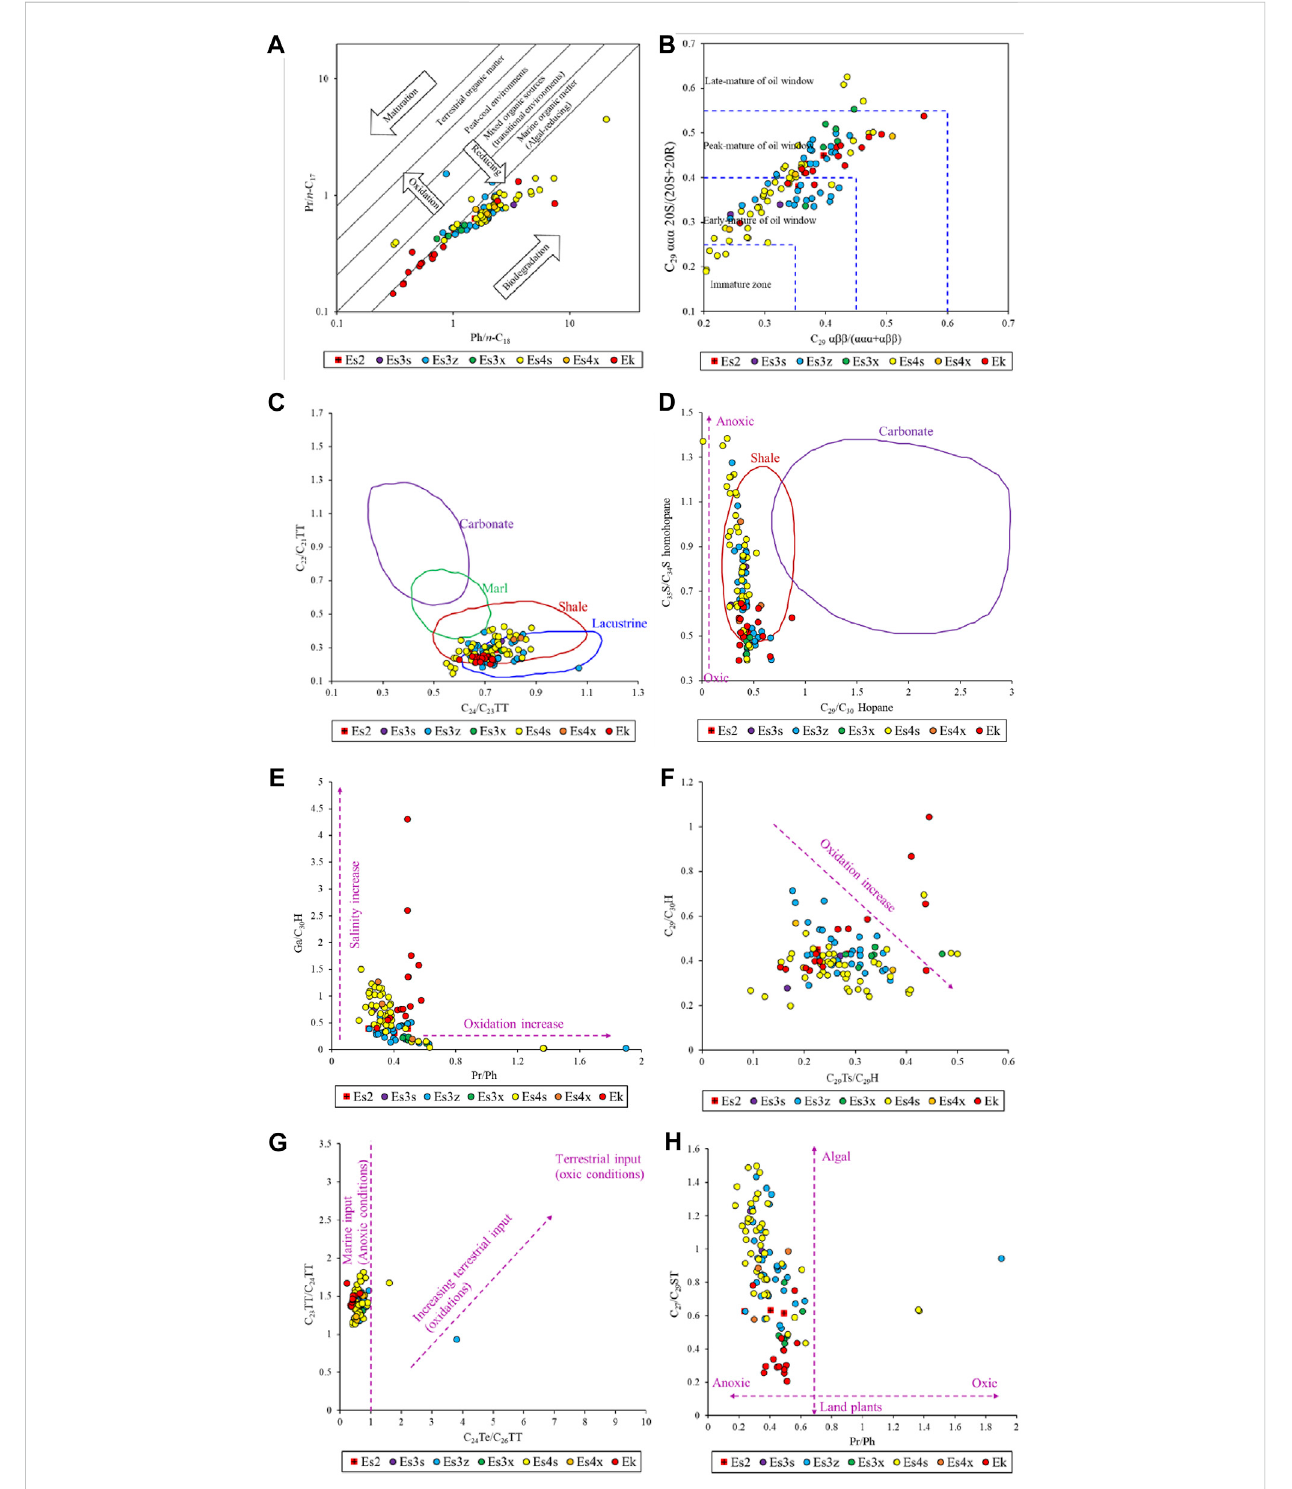
FIGURE 7 Scatter plots of maturity, lithology depositional environment and source indicators showing the variations of oil samples from different formations. (A) Pr/ n -C 17 and Ph/ n -C 18 . (B) C 29 αββ /( ααα + αββ ) and C 29 ααα 20S/(20S+20R). (C) C 24 /C 23 TT and C 22 /C 21 TT. (D) C 29 /C 30 Hopane and C 35 S/C 34 S homohopane. (E) Pr/Ph and Ga/C 30 H. (F) C 29 Ts/C 29 H and C 29 /C 30 H. (G) C 24 Te/C 26 TT and C 23 TT/C 24 TT. (H) Pr/Ph and C 27 /C 29 ST. [ (A) revised from Shanmugam, 1985; (B) revised from Hakimi et al., 2022; (C,D) revised from Al-Khafaji et al.,